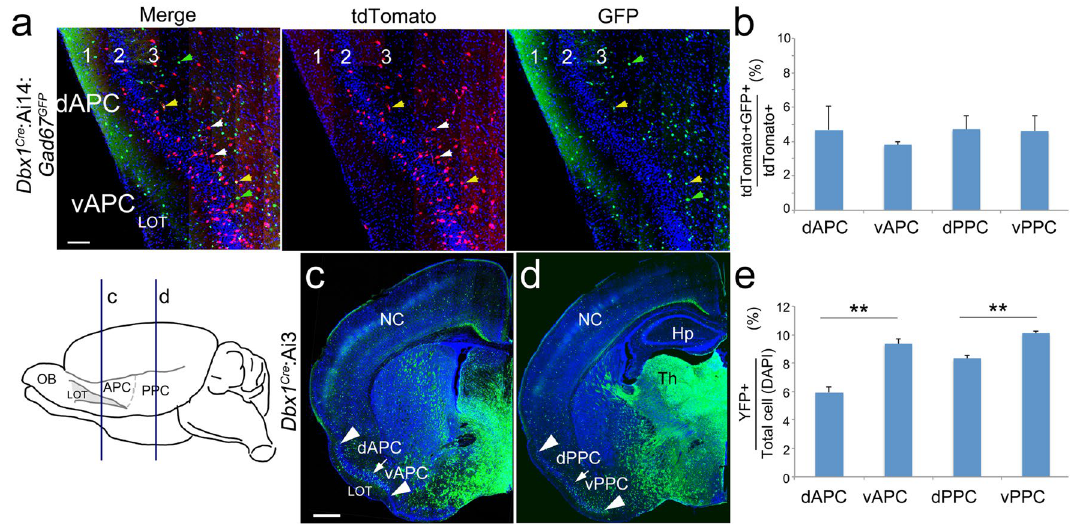
Figure 2. The contribution of cells from the Dbx1 lineage in piriform cortex. ( a ) Coronal sections at the level of the APC from Dbx1 Cre :Ai14: Gad67 GFP cortex at P30. Cells of the Dbx1 lineage were labeled by tdTomato, and inhibitory interneurons were labeled by GFP. GFP-positive and tdTomato-positive cells are indicated by green and white arrowheads respectively, while double-labeled cells are indicated by yellow arrowheads. ( b ) Quantification of the percentage of interneurons in the Dbx1 lineage (number of GFP + tdTomato + cells/number of tdTomato + cells). About 4% of the Dbx1 lineage cells are inhibitory interneurons, across the PC (n = 3). ( c , d ) Coronal sections of Dbx1 Cre :Ai3 cortex at P7 at the level of the anterior piriform cortex (APC) and posterior PC (PPC), as indicated on the left. Cells of the Dbx1 lineage were labeled by YFP (green); nuclei were stained with DAPI (blue). The APC and PPC are further divided into dorsal and ventral subregions. Arrowheads mark the dorsal and ventral ends of the PC, and arrow marks the border between dorsal and ventral PC. ( e ) Density of cells of the Dbx1 lineage (number of YFP + cells/number of total cells) measured in a radial column in PC subregions. Dbx1 cell denisty is significantly higher in ventral PC regions (n = 3). LOT, lateral olfactory tract; OB, olfactory bulb; NC, neocortex; Hp, hippocampus. Scale bars, 100 µm ( a ) and 500 µm ( c